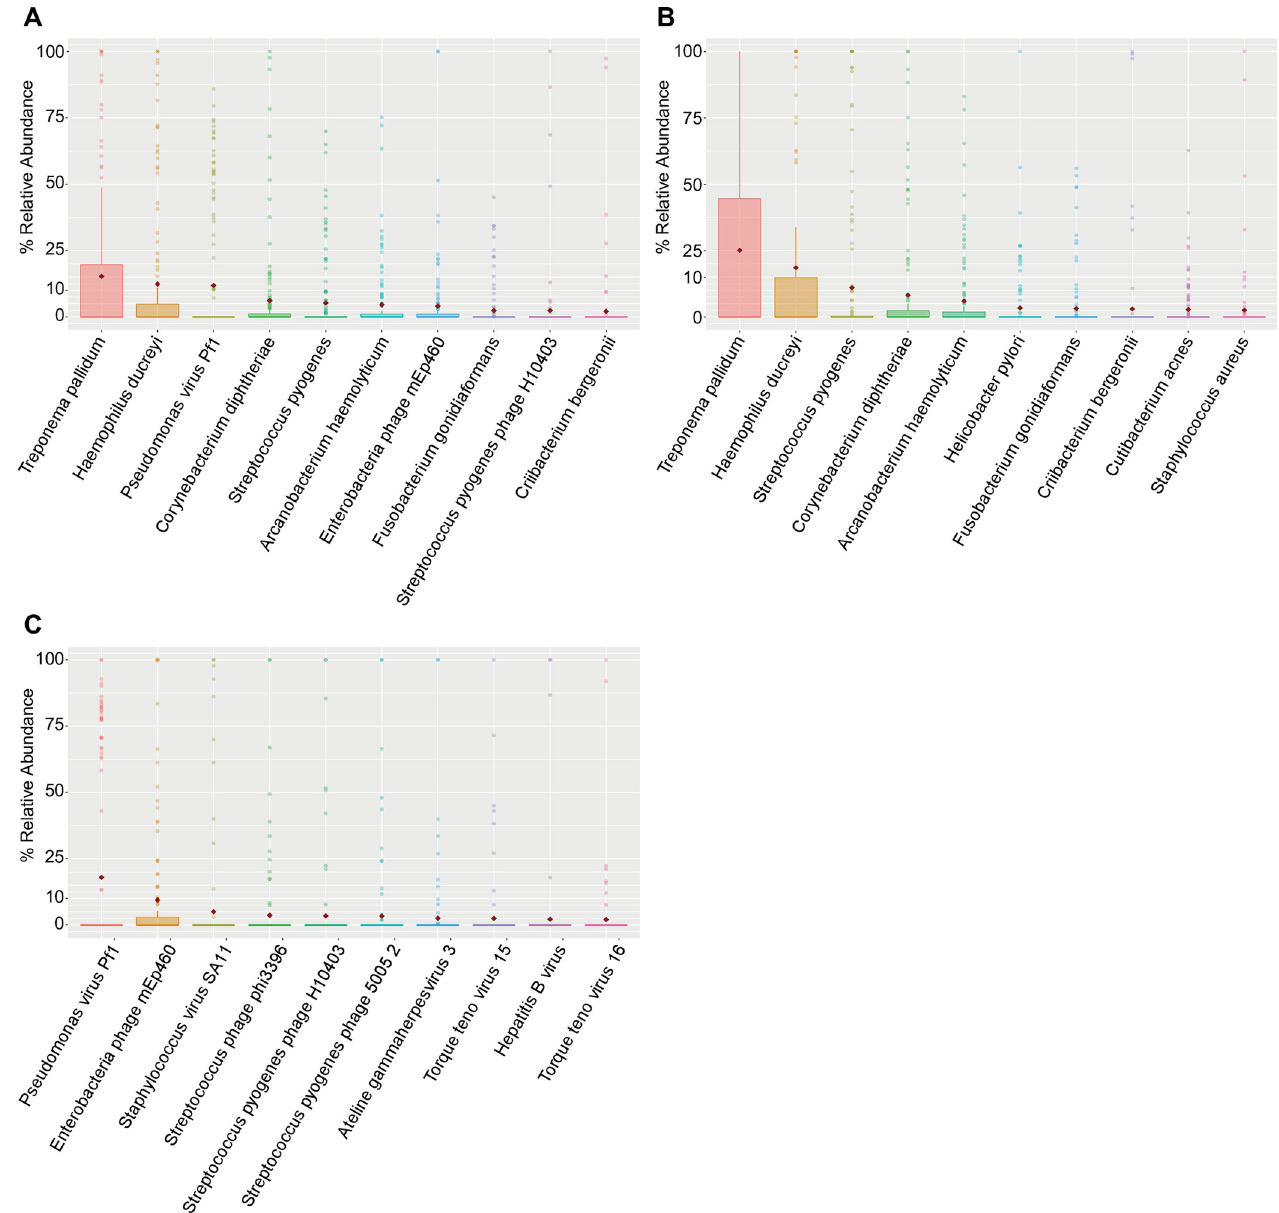
Fig 1. Top 10 most relatively abundant taxa from ulcers in the stringent dataset. Box and whisker plots using (A) all identified taxa, (B) only bacterial taxa, and (C) only viral taxa. All box plots show medians with hinges corresponding to the 25 th and 75 th percentiles and whiskers extending no further than 1.5x interquartile range from the hinges. Red diamonds signify means. Medians are shifted toward zero due to the absence of many of the taxa in the majority of the specimens (N = 139).